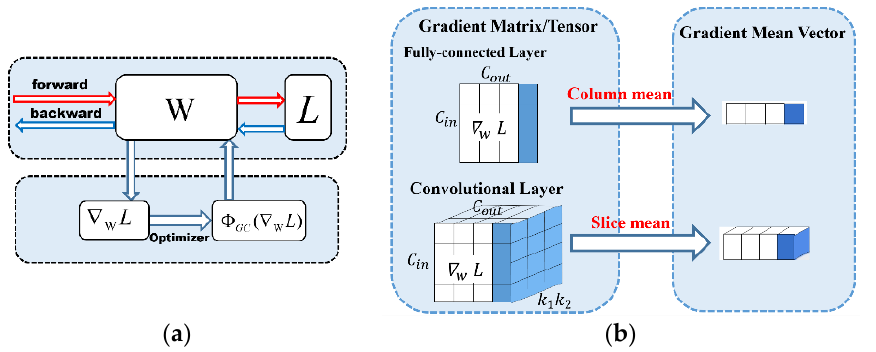
Figure 4. Schematic diagram of gradient centralization. ( a ) Schematic diagram of using GC; ( b ) GC operation of gradient matrix/weight tensor.